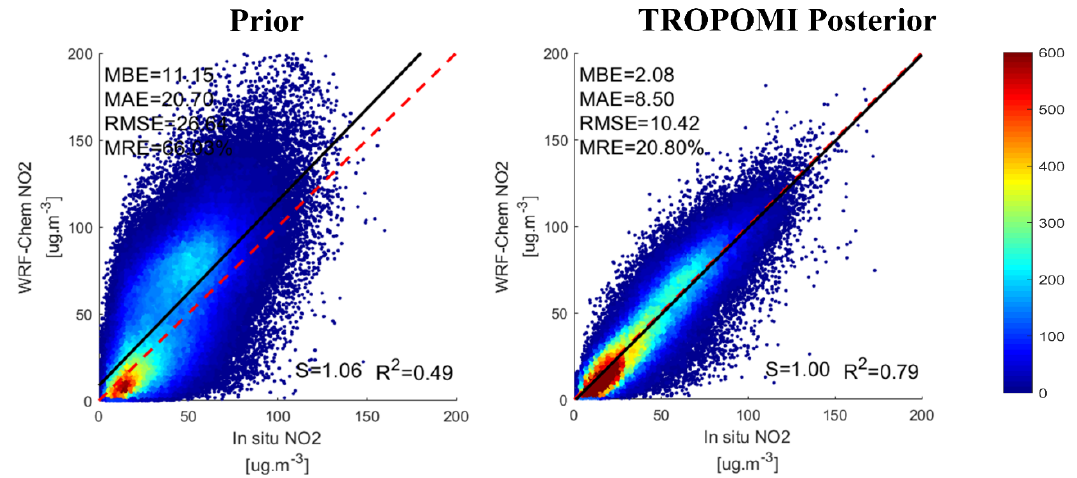
Figure 4. Correlation analysis of in-situ surface NO 2 concentrations (from China National Environmental Monitoring Centre) and simulated NO 2 using prior (MEIC-2017) and TROPOMI posterior (top-down W_2018 and W_2019) inventories. MBE: Mean Bias Error, MAE: Mean Absolute Error, RMSE: Root Mean Squared Error, MRE: Mean Relative Error.